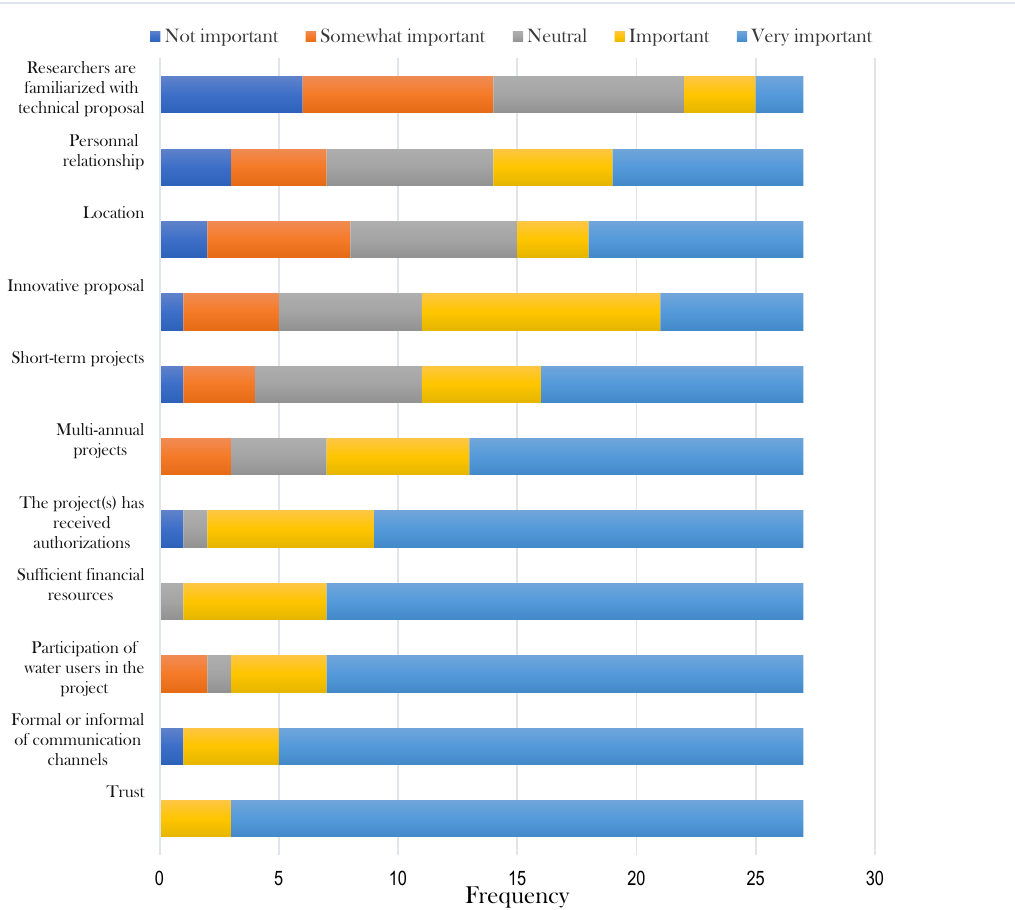
Figure 3. Participants’ responses when answering the question: How important are the following aspects for working with other institutions on water management or recharge projects? (n =